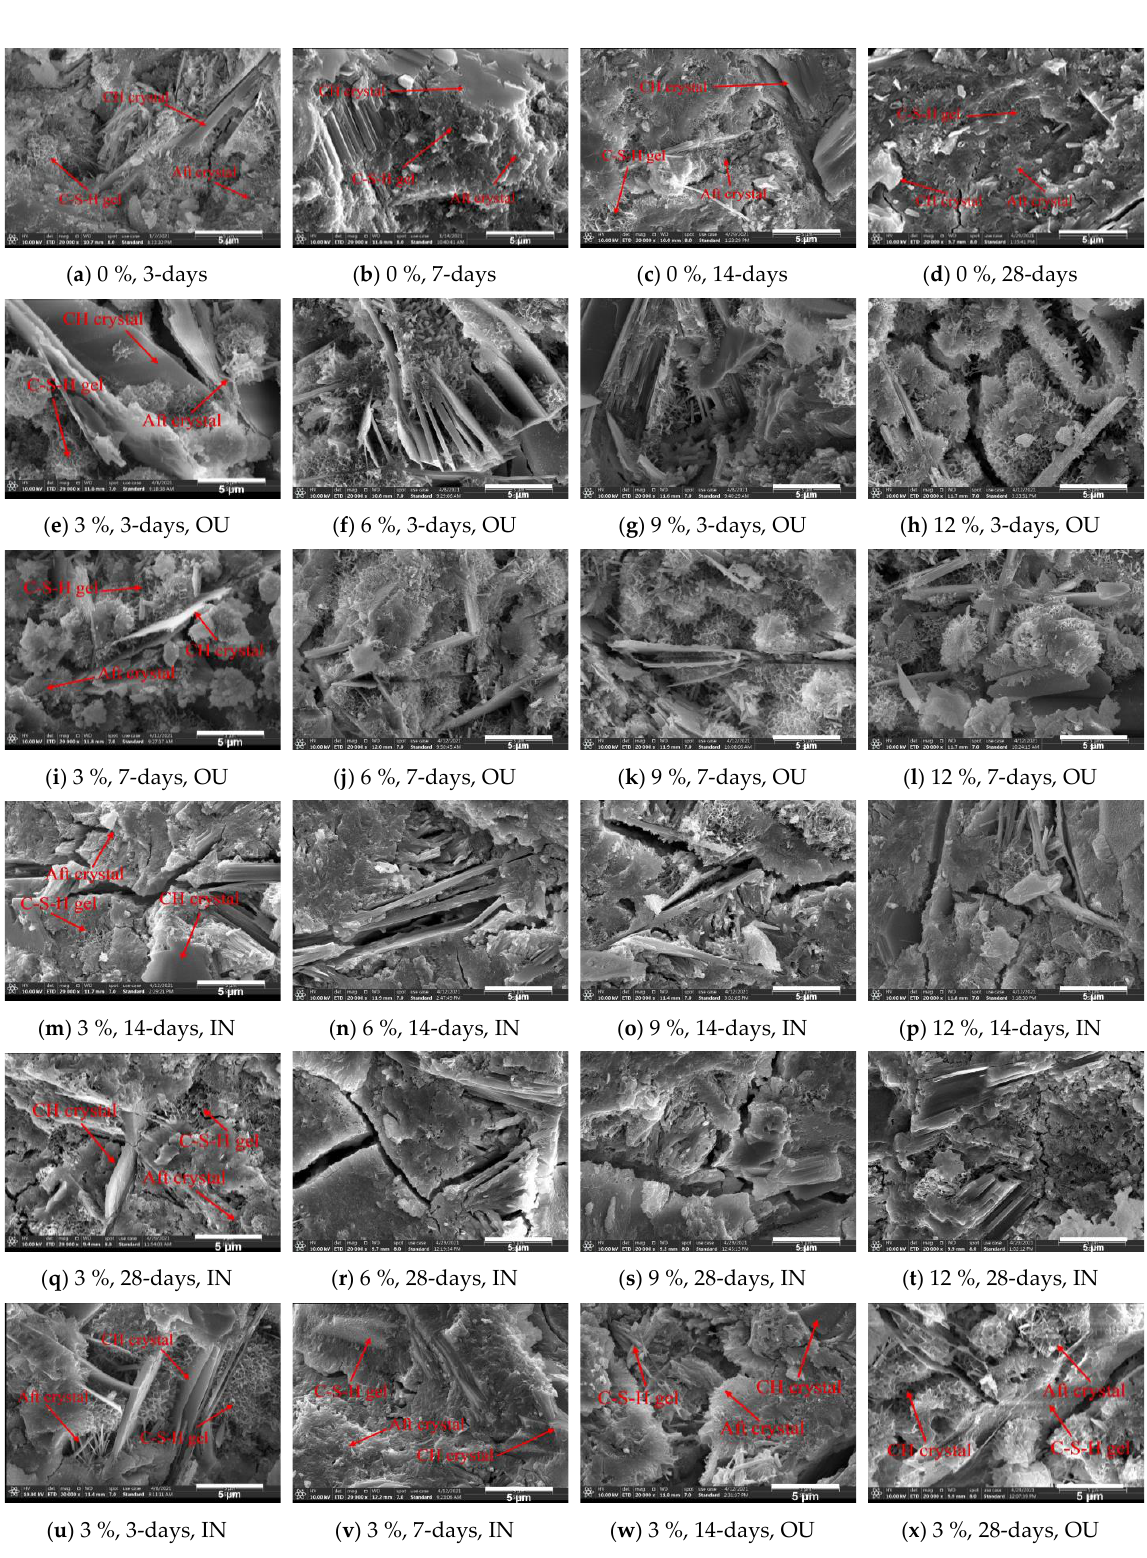
Figure 4. The SEM images of the HECM: ( a ) 0%, 3 days; ( b ) 0%, 7 days; ( c ) 0%, 14 days; ( d )